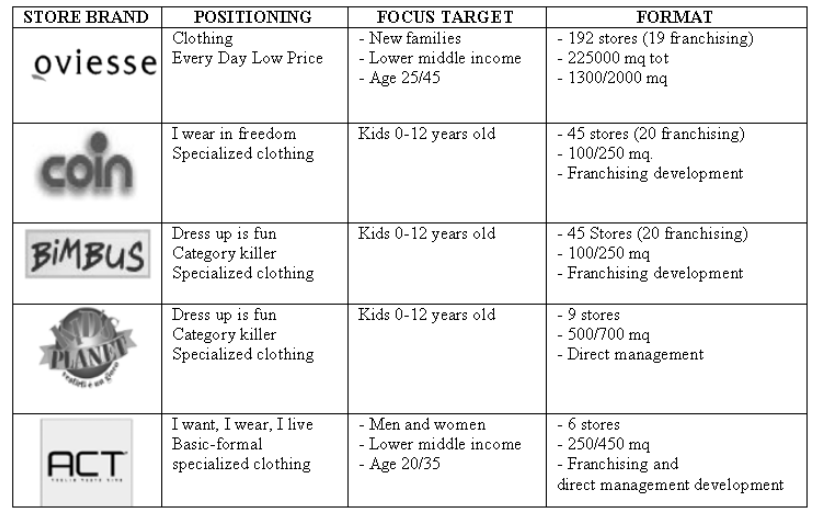
Figure 4: The Store Brands of Gruppo Coin